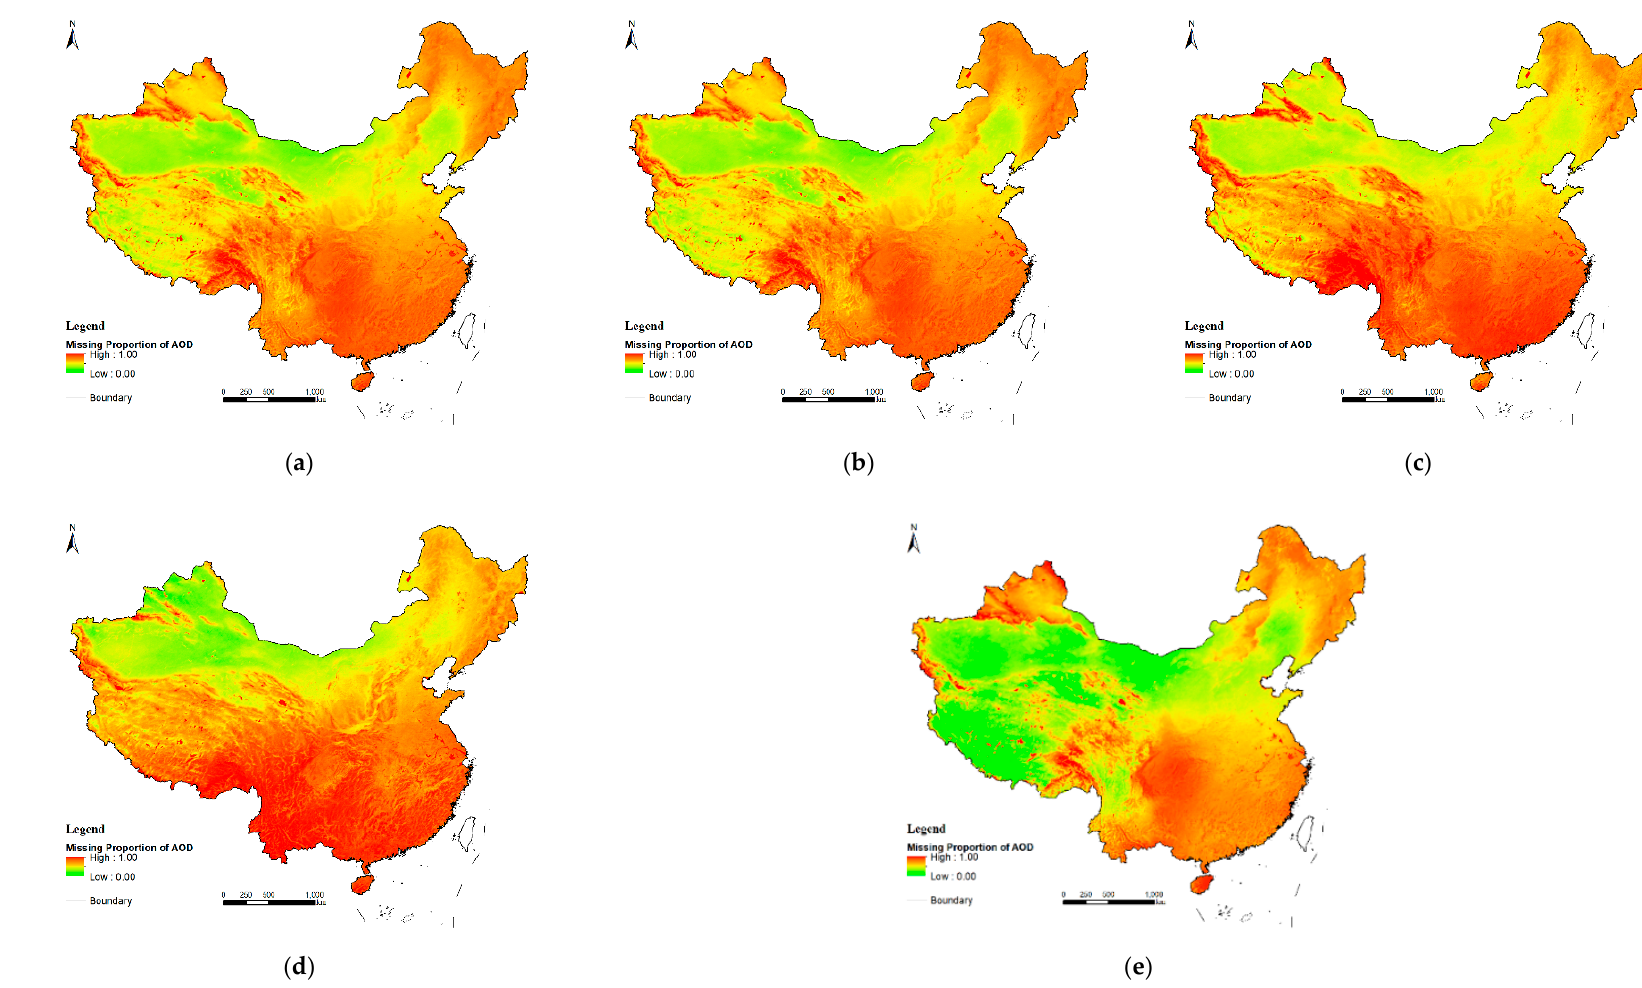
Figure 3. Spatial distributions of the proportions of missing AOD for 2015–2018 ( a ), the springs of 2015–2018 ( b ), the summers of 2015–2018 ( c ), the autumns of 2015–2018 ( d ) and the winters of 2015–2018 ( e ).